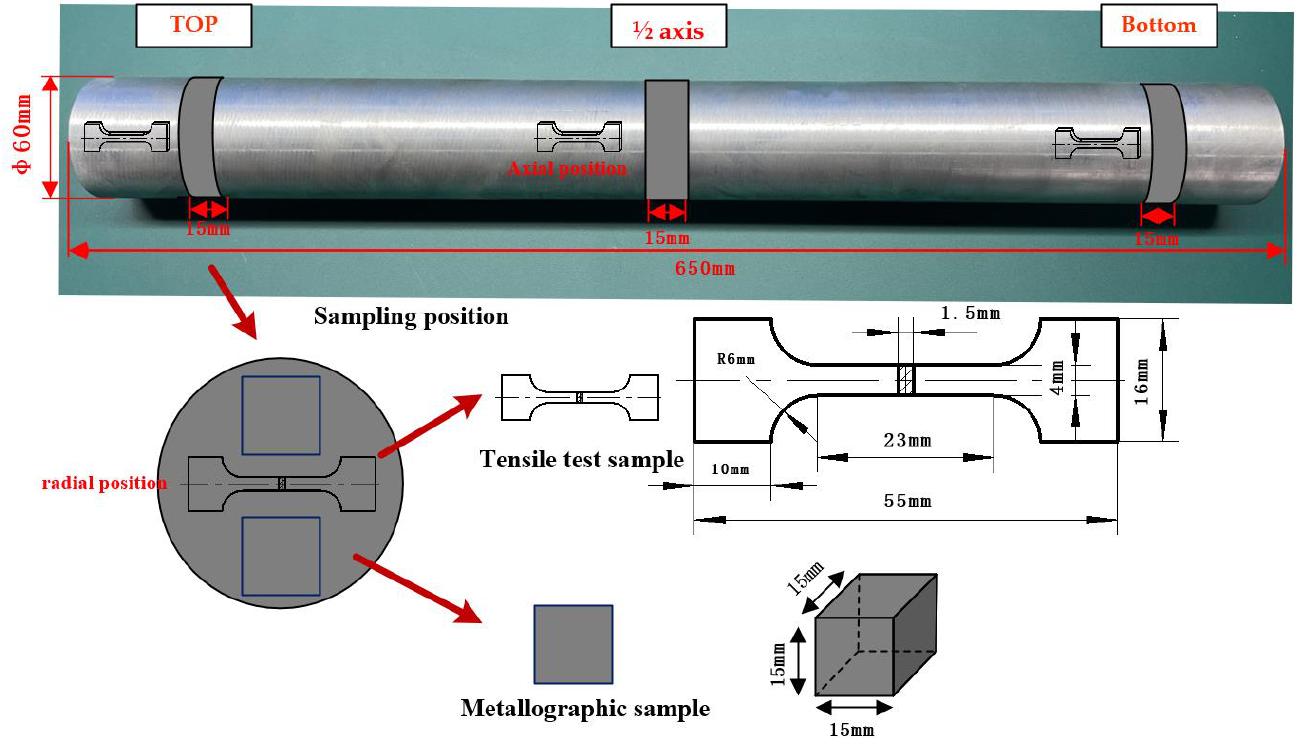
Figure 2. Schematic diagram showing representative positions of microstructure samples and tensile test samples taken from the ingot.